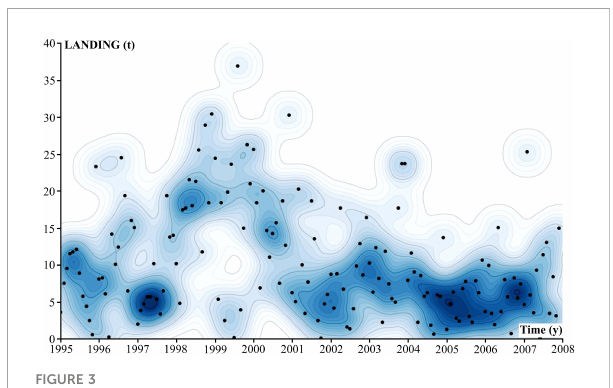
FIGURE 3 Scatterplot of the shark bycatch landed by the acoupa weak fi sh ( Cynoscion acoupa ) gillnet fi sheries in Para ́ state between January 1995 and December 2007. The blue color gradient represents the density of shark catches (darker blue = higher